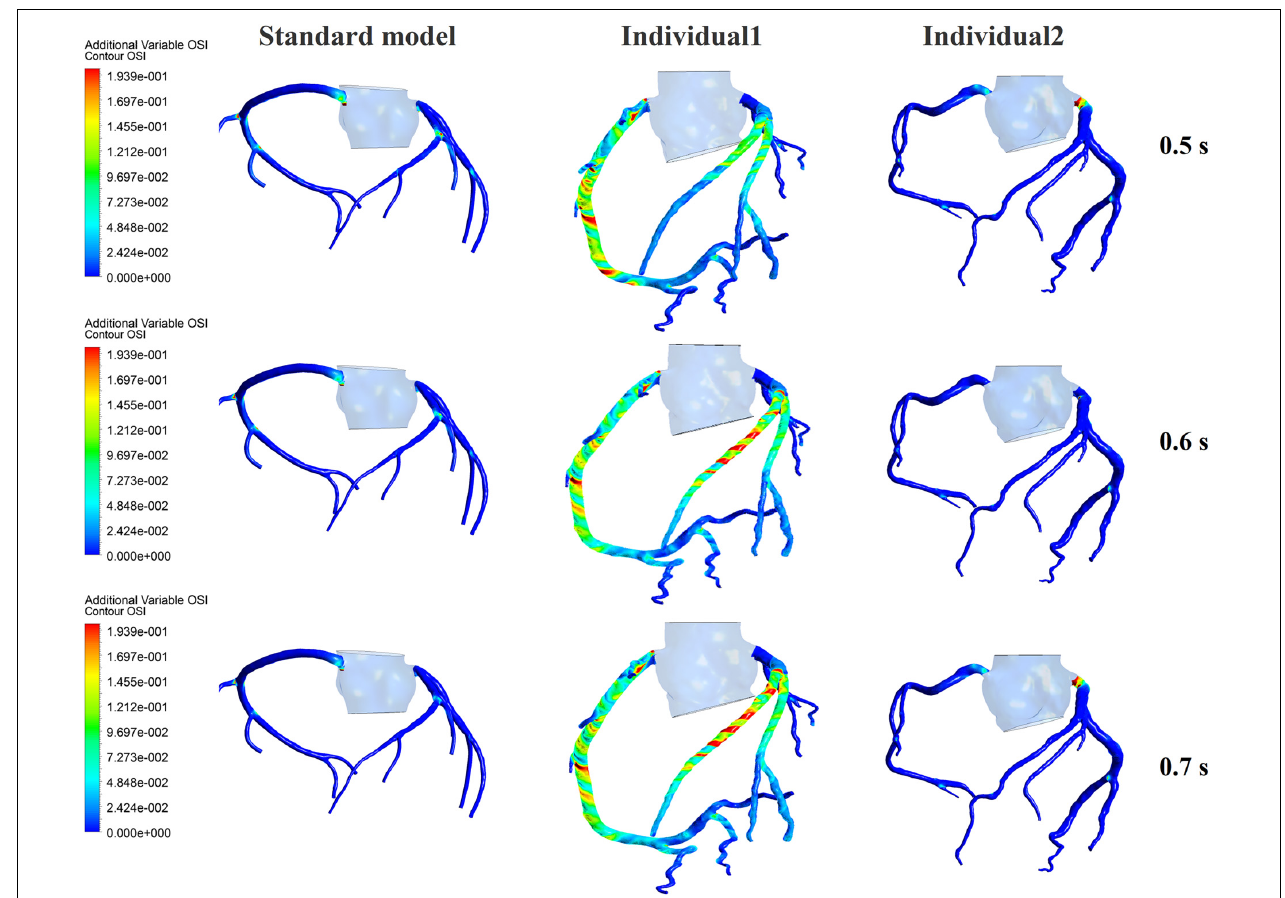
FIGURE 9 | The variations of global OSI of three coronary arteries under different pressurization durations.